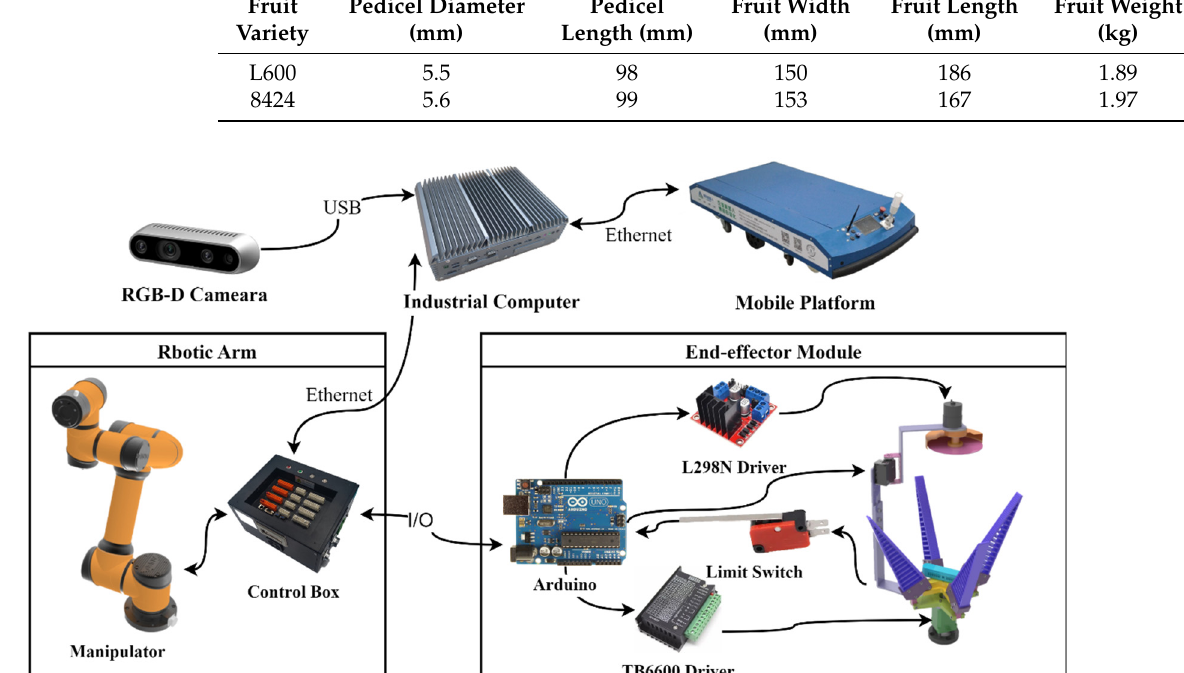
Figure 2. Schematic of the proposed watermelon-harvesting robot.